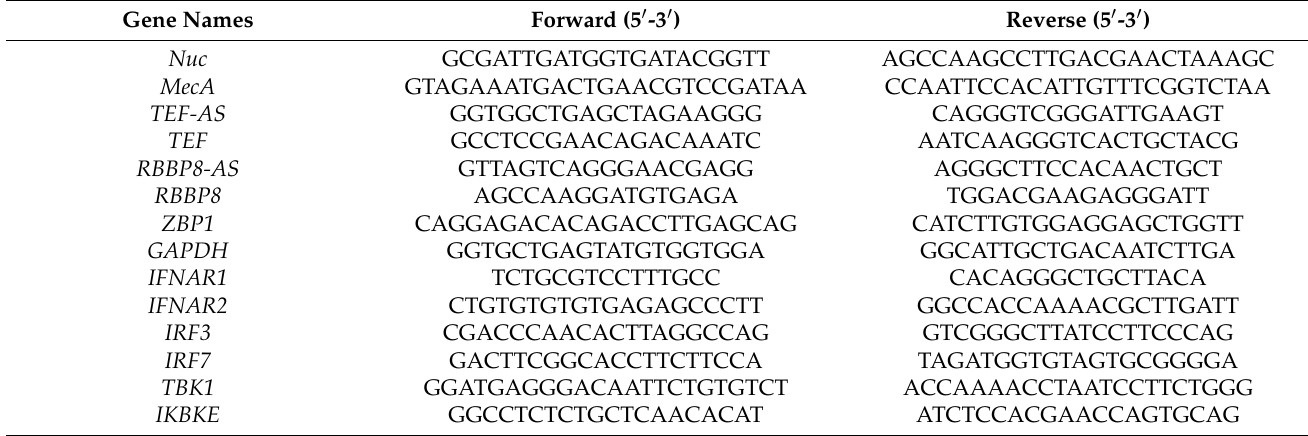
Table 1. Primer information used in this